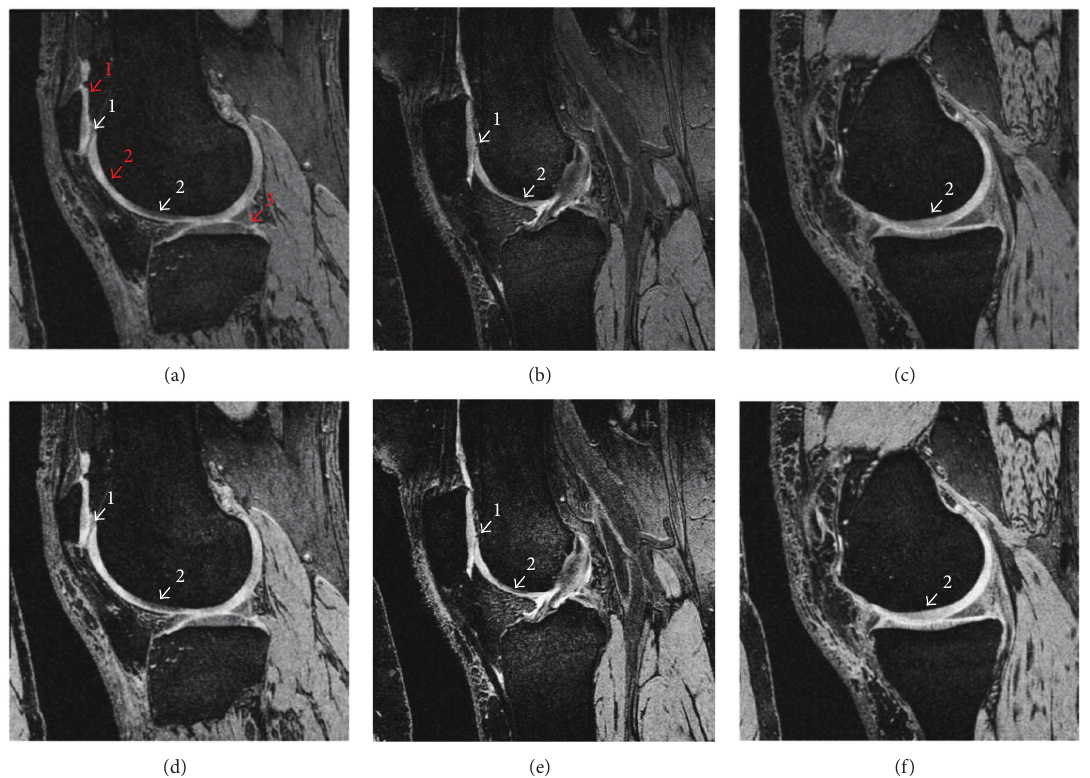
Figure 2: Manifestations of contrast enhancement effect on MR image from medial, central, and lateral sides of the knee joint to represent overall enhancement impact on the stack of 2D MR images. (First row from left to right) Original MR knee image from different sides: (a) medial, (b) central, and (c) lateral. (Second row from left to right) BBCCE enhanced MR knee image from different sides: (d) medial, (e) central, and (f) lateral. Knee cartilage is known as (in red arrows with label): (1) patellar cartilage, (2) femoral cartilage, (3) tibial cartilage. Prominent knee features in this image include (in white labeled arrows): (1) femoral sulcus and (2) Intensity variation within